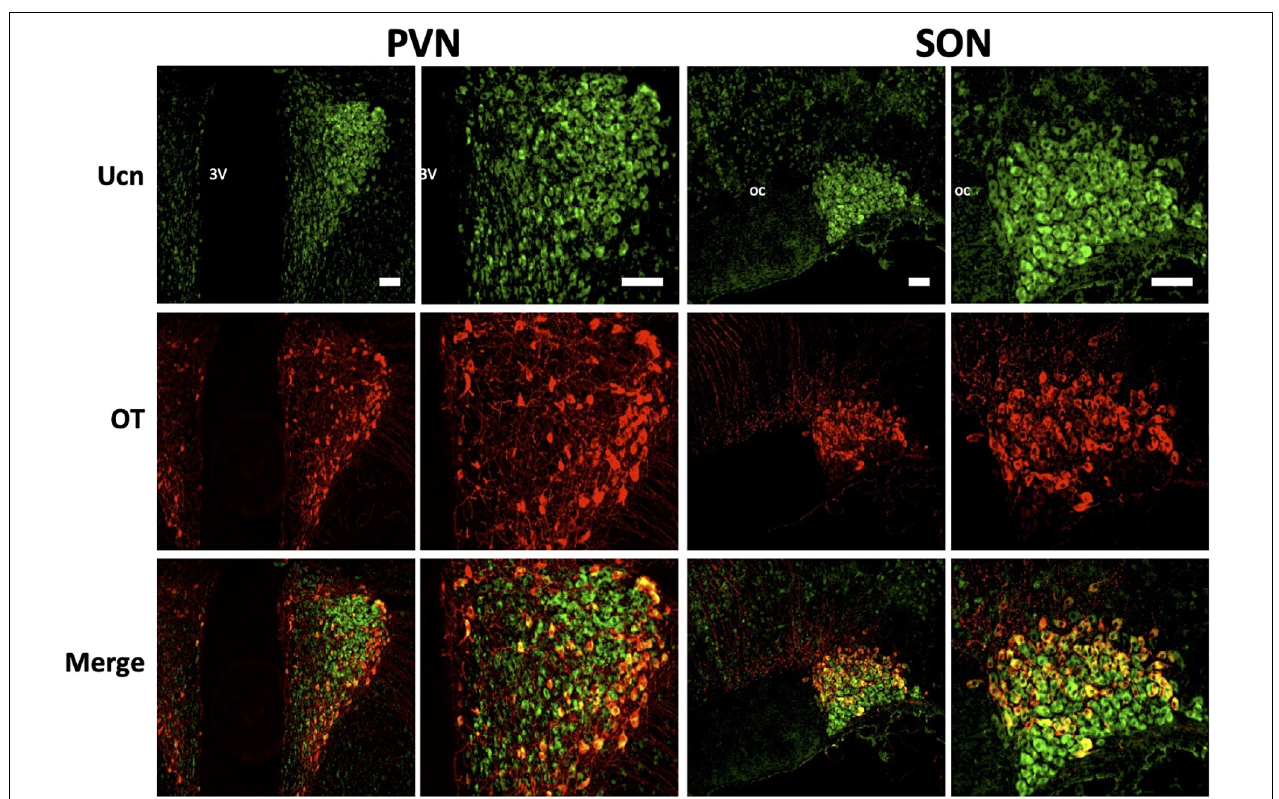
FIGURE 7 | Representative images of colocalisation of Ucn with OT in SON and PVN. Double-labelling with antibodies directed against Ucn and OT showed an apparent level of colocalisation within a proportion of oxytocinergic magnocellular cells within the PVN and SON. Images of PVN show robust staining of Ucn within a larger number of neurons in the lateral as well as ventral magnocellular divisions, with number of OT stained neurons appearing lower and more diffuse within these divisions. Images of SON show robust staining of Ucn in both dorsal and ventral divisions, however, OTstaining, as well as colocalisation of Ucn and OT is more limited toward the dorsal aspect of the nuclei. 3V, Third Ventricle; oc, optic chiasm; Ucn, Urocortin; OT, oxytocin. Scale Bar = 100 µ